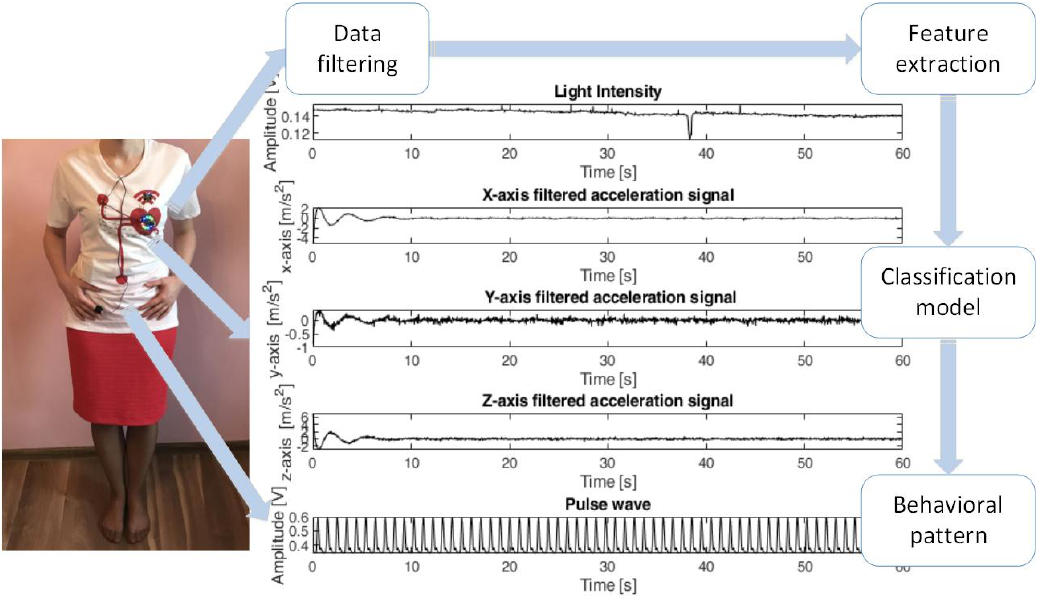
Figure 4. The diagram displays standing volunteer during experiment protocol and the plot of light intensity, acceleration, and pulse wave signals as well as output from classification model.